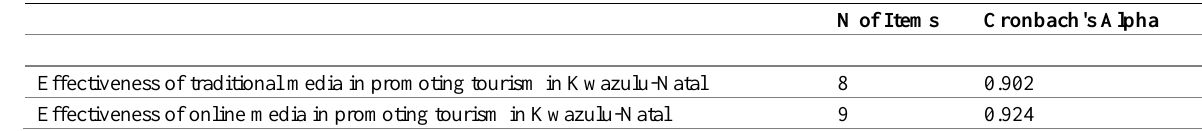
Table 1 below reflects the Cronbach’s alpha score for all the items that constituted the questionnaire. Table 1: Cronbach’s alpha score